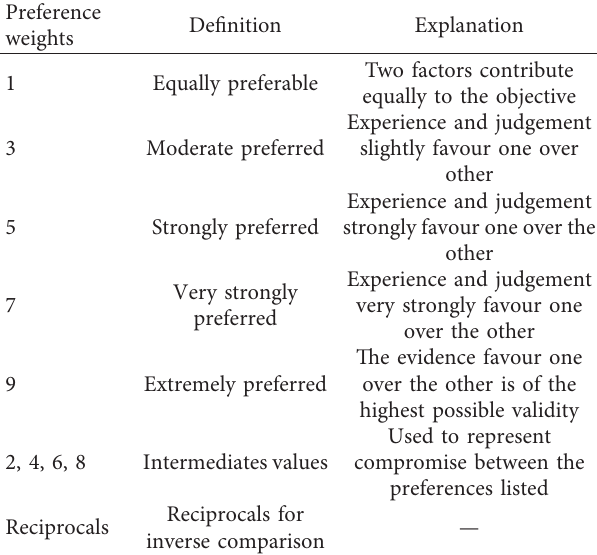
Table 5: Definition and explanation of preference weights based on Saaty’s theory.